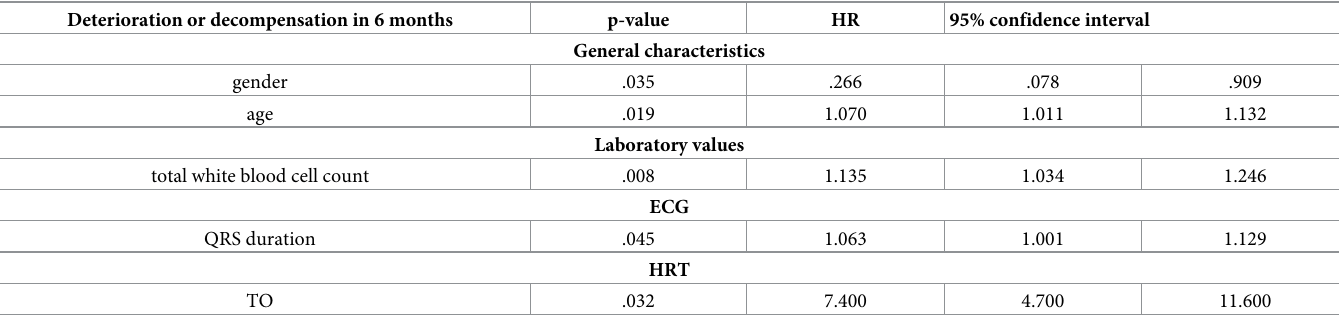
Table 3. Univariate time-to-event analysis (forward step-wise likelihood quotient) was performed to predict deterioration or decompensation in 6 months. Deterioration or decompensation in 6